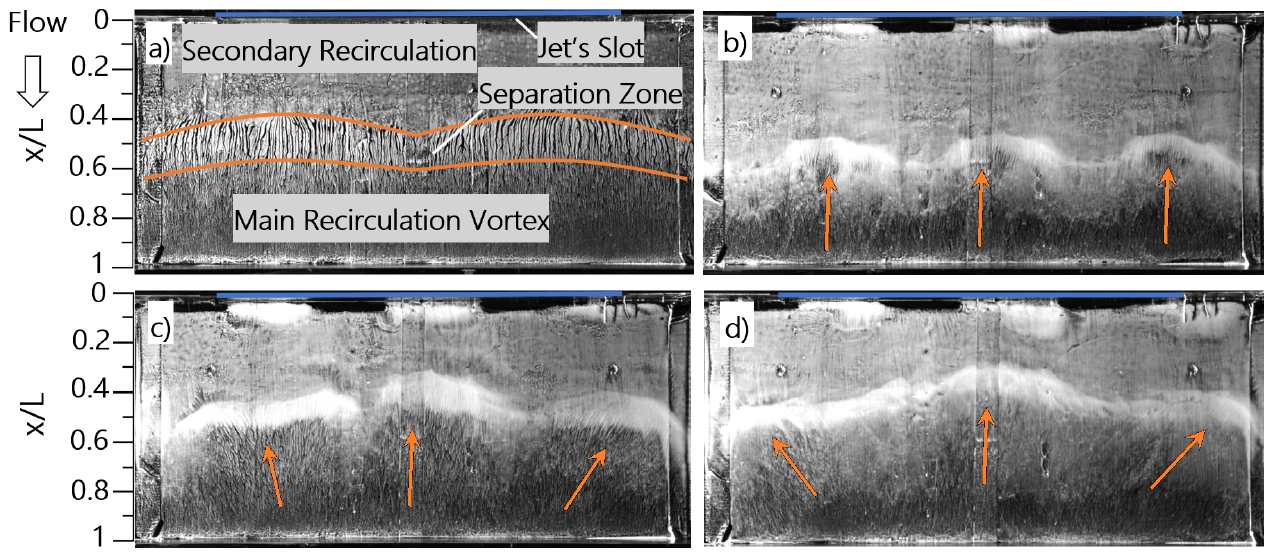
Figure 12. Surface oil flow visualisations for Re D ≈ 50,000; sharp edge at LE; different J : ( a ) no jet, ( b ) J = 0.11 kg/m · s 2 , ( c ) J = 0.44 kg/m · s 2 , and ( d ) J = 0.96 kg/m · s 2 .